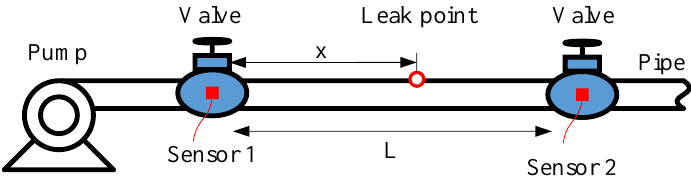
Figure 1. Schematic diagram of the process of pipeline leak detection.